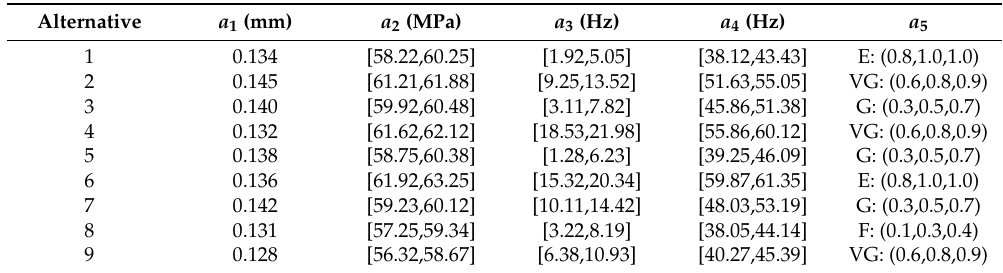
Table 3. The attribute data for nine alternative structural